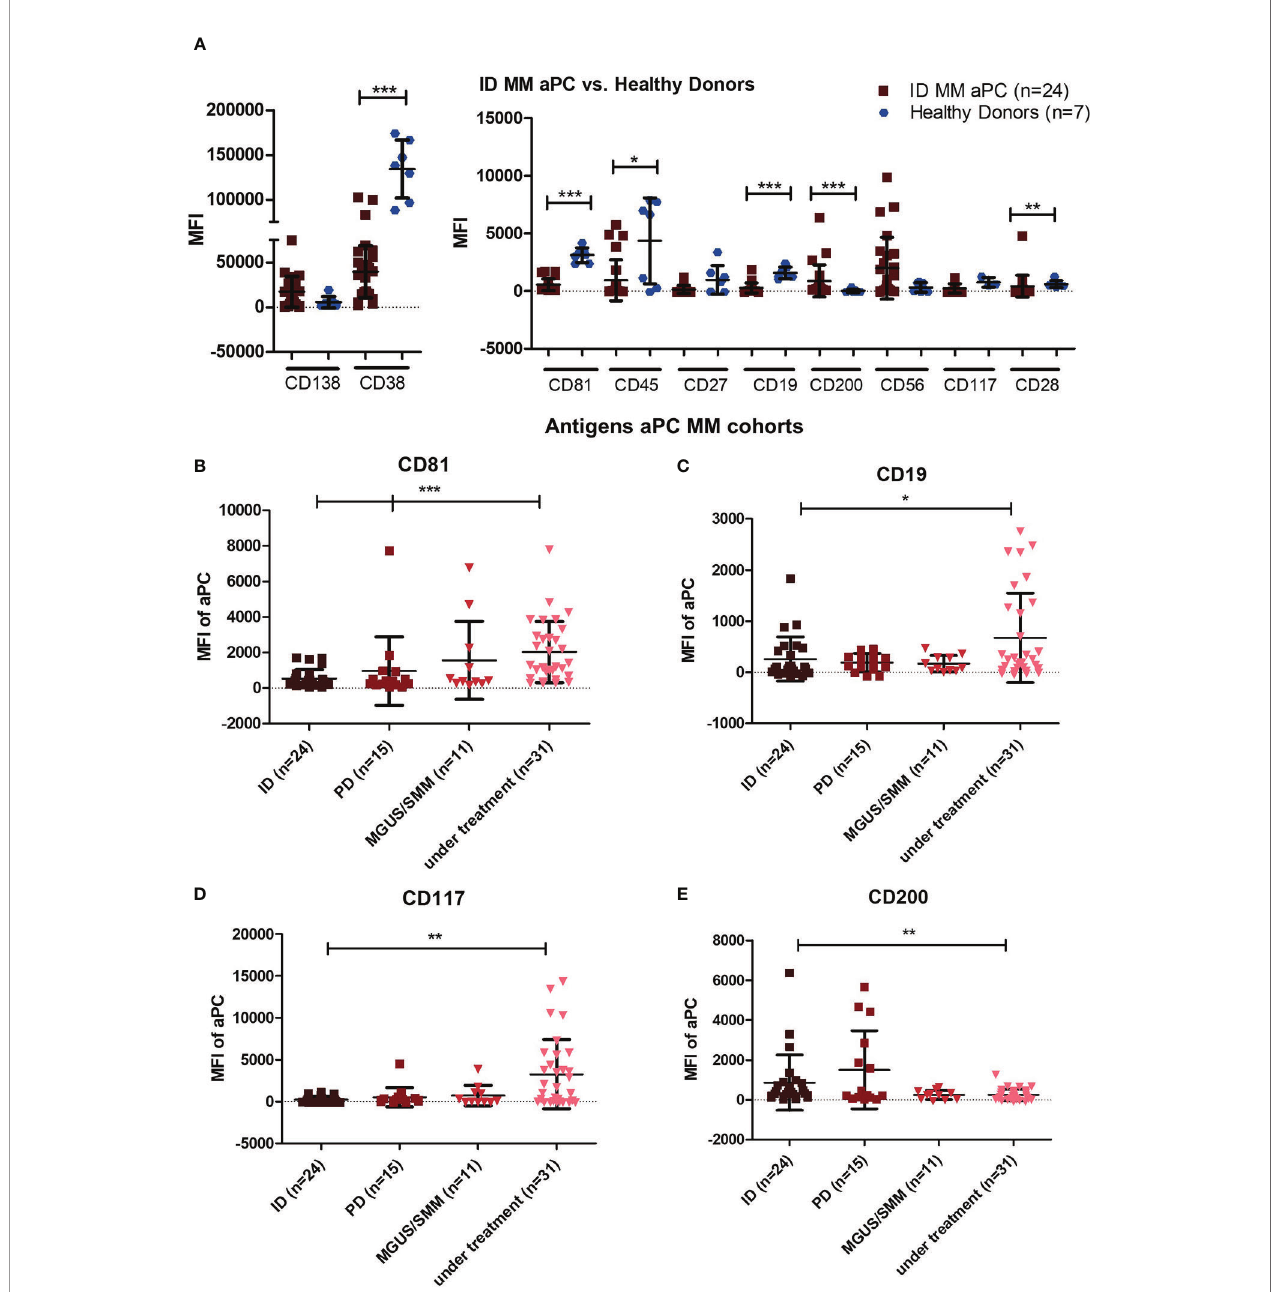
FIGURE 2 | Phenotypic analysis of the 10 antigens on aPC in BM of MM patients and healthy donors. (A) Geometric mean fl uorescence intensity (MFI) analysis of healthy donor samples compared to aPC of ID MM patients (p < 0.0001; Mann-Whitney U test). Due to technical errors, four healthy donor samples had to be excluded for CD117 MFI analysis. (B) MFI analysis of CD81 solely on aPC for the investigated cohorts (p < 0.0001; p = 0.0004; Mann-Whitney test). (C) MFI analysis of CD19 solely on aPC for the investigated cohorts (p = 0.0469; Mann-Whitney U test). (D) MFI analysis of CD117 solely on aPC for the investigated cohorts (p = 0.0019; Mann- Whitney U test). (E) MFI analysis of CD200 solely on aPC for the investigated cohorts (p = 0.0056; Mann-Whitney U test). ***p < 0.0001; **p < 0.001; *p <